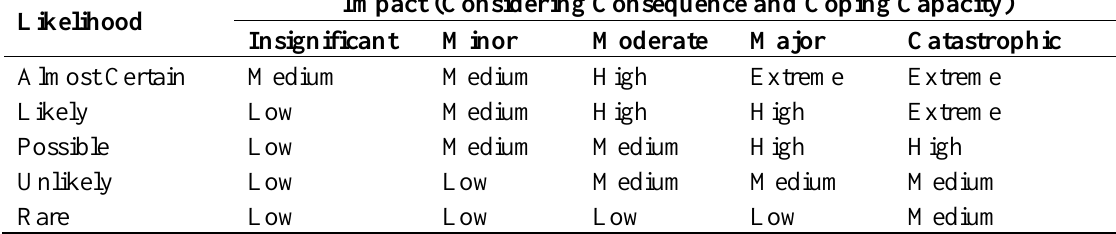
Table 1. Matrix used to assess climate-sensitive health risks in Kiribati, in terms of their likelihood and